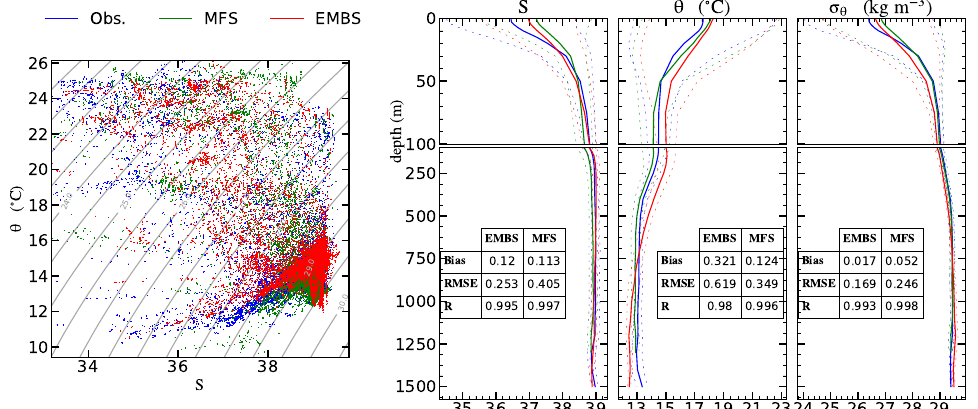
Figure 14. North Aegean Sea θ / S diagram containing all profiles (casts) for the period 1985–2014, and average vertical profiles of S , θ and σ θ in the North Aegean Sea. Observations (blue), MFS simulation (green) and EMBS simulation (red) both calculated using profiles at the same place and time as the observations. The range of one standard deviation is shown with dashed lines as a measure of overall variability. Additional metrics for the averaged profiles (Bias, RMSE and R-coefficient) are shown for the two simulations compared to observations, with all correlations being statistically significant ( p -value < 0.01).